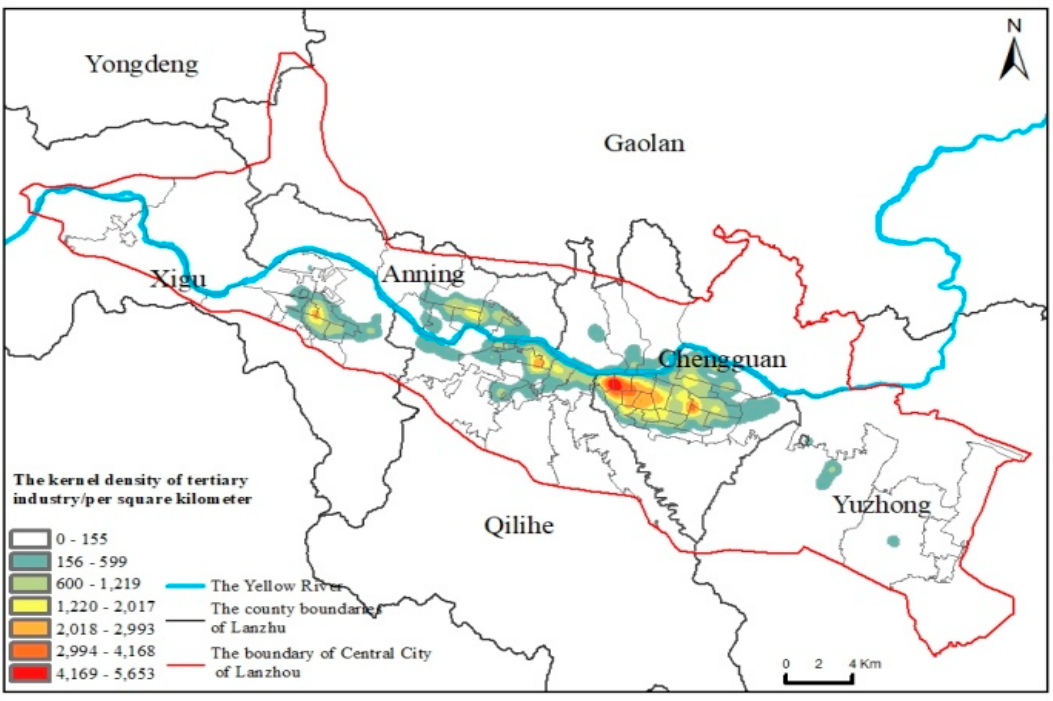
Figure 7. The kernel density distribution of tertiary industry.